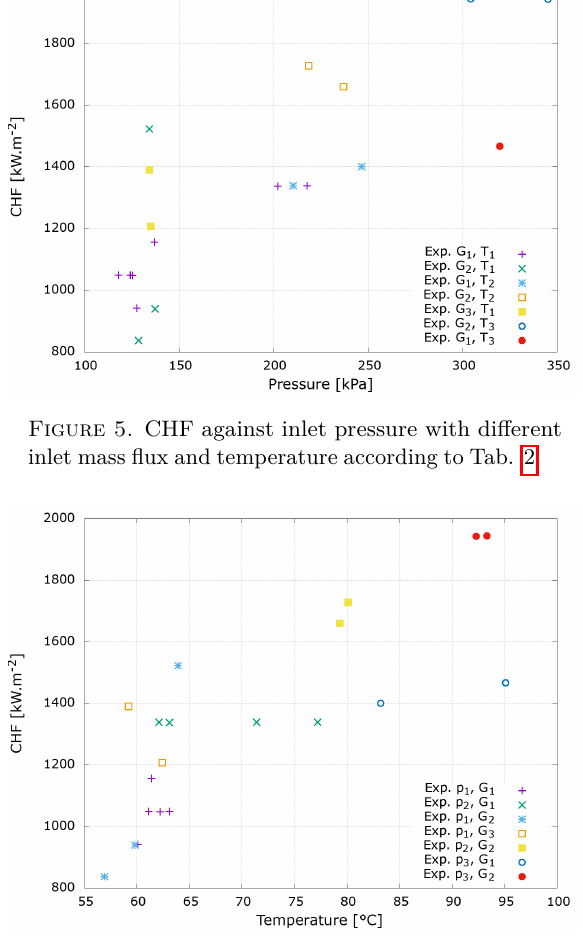
Figure 6. CHF against inlet temperature with dif- ferent inlet pressure and mass flux according to